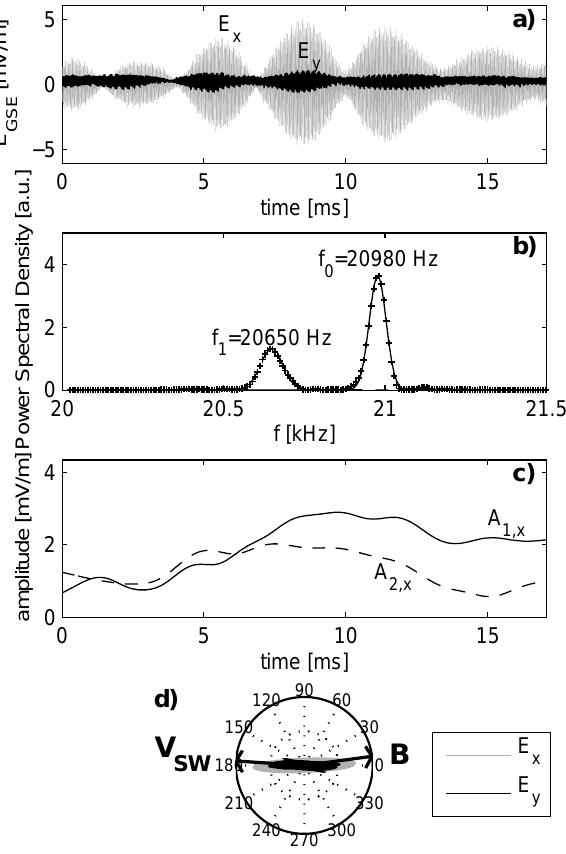
Fig. 2. Analysis procedure of a typical wave packet: (a) two com- ponents of the electric field in GSE coordinates, (b) identification of the two peaks in the power spectral density (continuous curves are gaussian fits), (c) verification that the amplitudes and the phases (not shown) indeed vary slowly in time, (d) hodogram to compare the polarisation with the orientation of the magnetic field. The direc- tion of the solar wind velocity varies and is not necessarily aligned with the magnetic